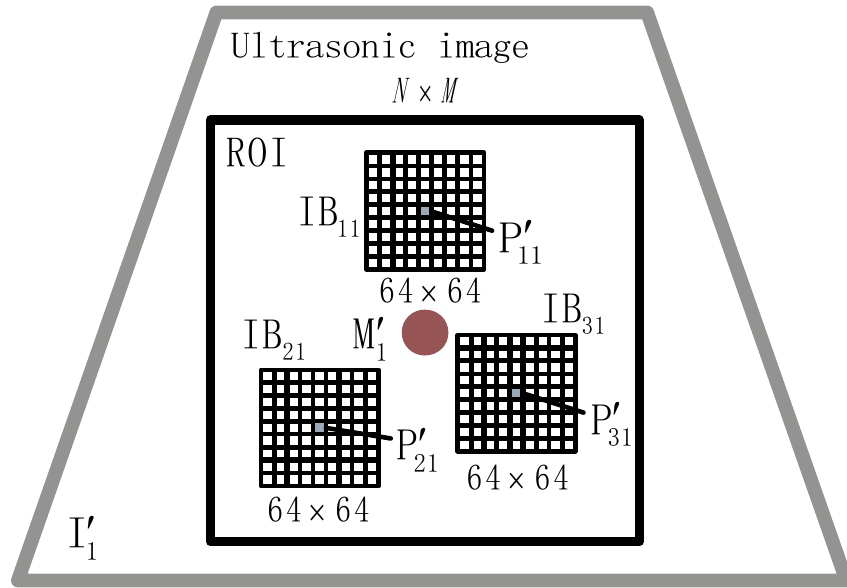
Figure 4. Image blocks around points in the ROI area.